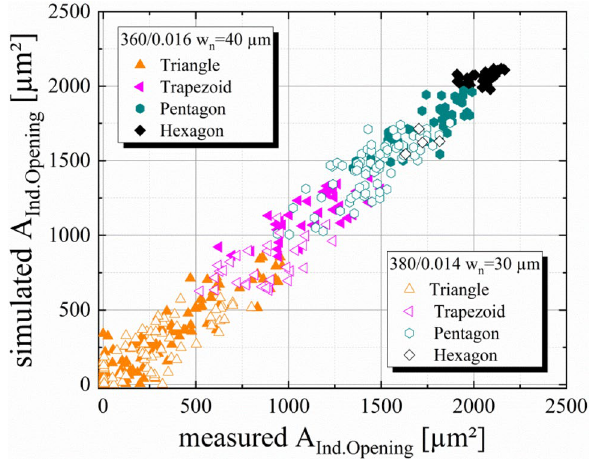
Figure 3. Experimental verification of the simulated area of individual openings. For this verification, 27 microscope images per screen of the screen opening channels were taken and analyzed regarding the area of individual openings. Two screens with different mesh types are chosen. The first mesh has a mesh count MC = 380 1/inch and a wire diameter d = 14 µm (open symbols) with w n = 30 µm and the second mesh has a mesh count MC = 360 1/inch and a wire diameter d = 16 µm with w n = 40 µm (closed symbols). The screen angle of both screens is φ = 22.5°. The deviation of measurements is caused by manufacturing tolerances of w n , MC, d and ϕ , the mesh calendaring and an insufficient resolution of microscope